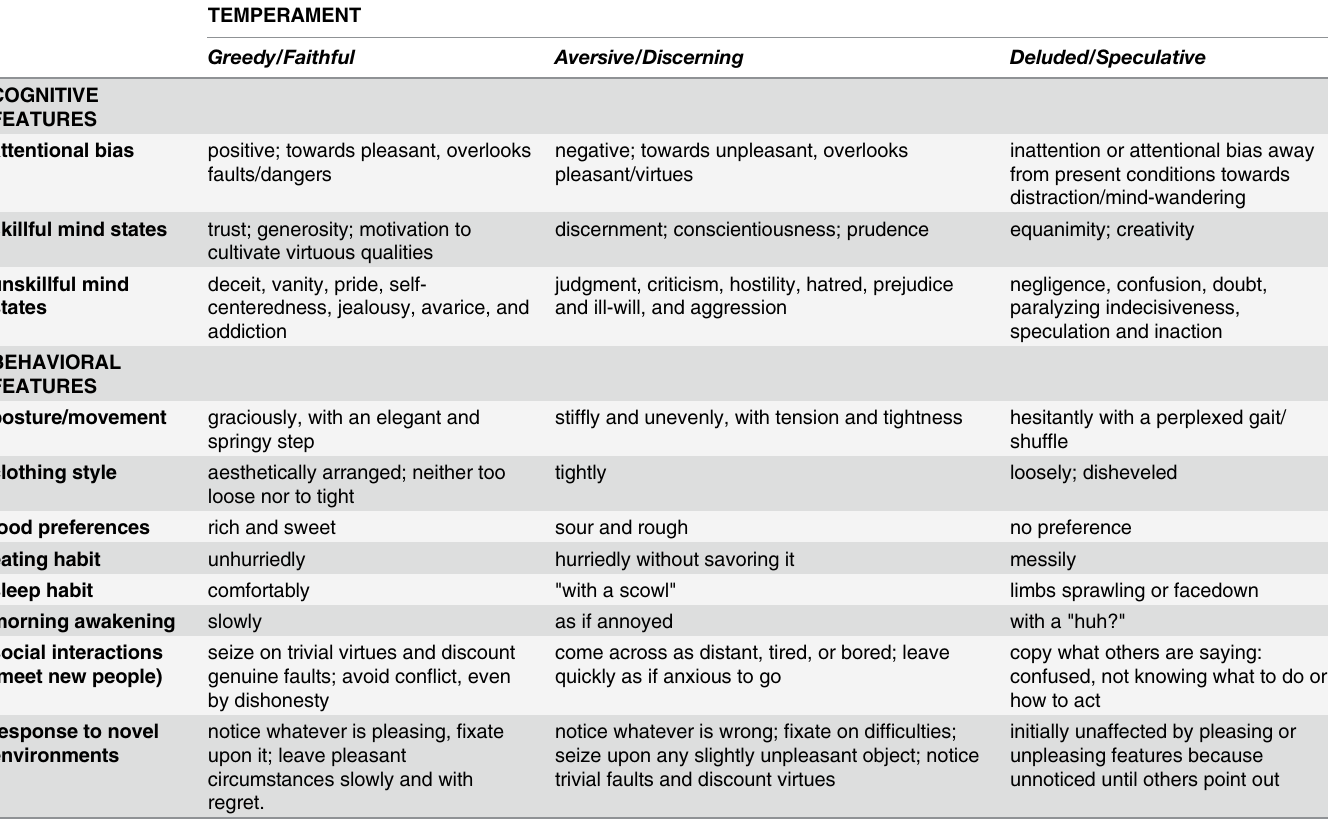
Table 1. Features of three Buddhist temperaments described in the Visuddhimagga by different characteristics.